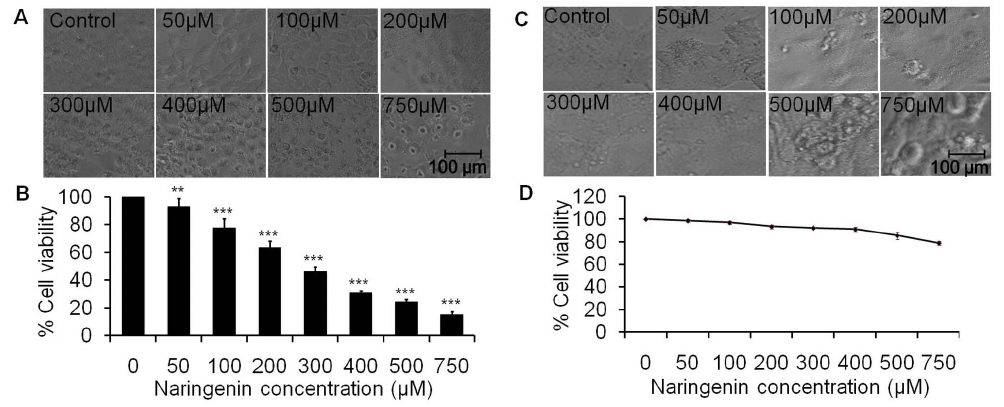
Figure 1. Invitro activity of naringenin against Human skin carcinoma A431 and normal HaCat cells. (A) Morphological view of live and dead cells of A431 cell line treated with 50 m M to 750 m M concentration of naringenin (B) The percent cell viability of A431 cells measured by a MTT assay at 24 h as described in the experimental section. (C) Morphological analysis of normal HaCat cell line treated with 50 m M to 750 m M concentration of naringenin. Photomicrographs were taken by inverted phase contrast microscope. (D) The percent cell viability of HaCat cell measured by a MTT assay at 24 h. Values are expressed as means 6 SD of at least three independent experiments, **p , 0.01 and ***p , 0.001 as compared with their respective control.